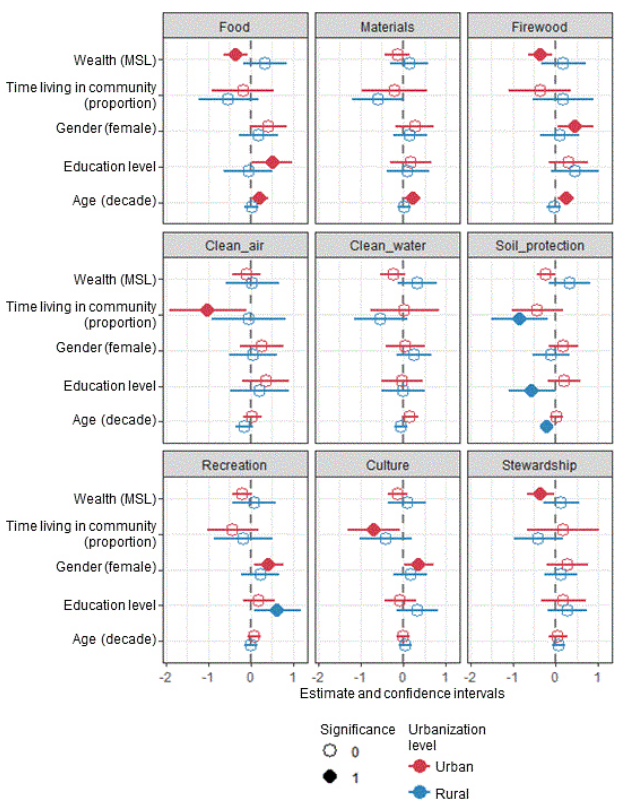
Fig. 4 . Relationship between socio-demographic characteristics and number of perceived limitations per ecosystem service types in urban and rural areas. Limitations were included in the models, but are omitted from the graph. Urban and rural analyses were performed separately for each ecosystem service, but are illustrated in the same plots. MSL, material style of life.